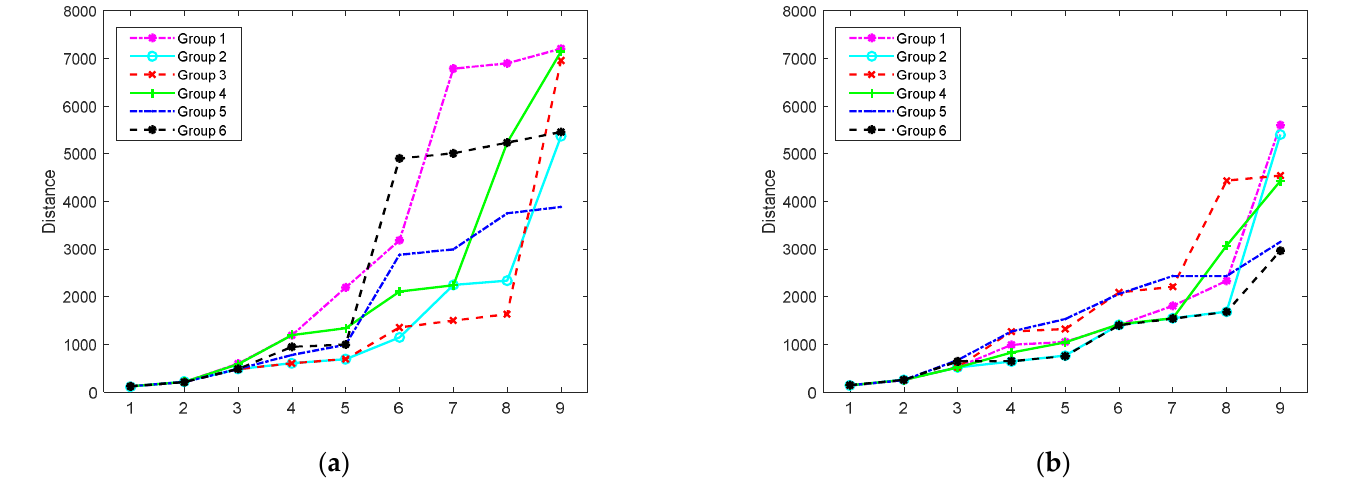
Figure 18. The length of the path required to complete the target search: ( a ) search using the conventional RRT algorithm and ( b ) search using the improved RRT algorithm.